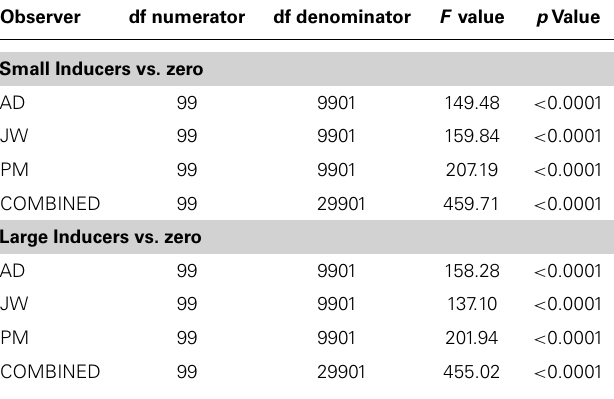
Table 1 | Degrees of freedom, F values and p values obtained from the single-sample Hotelling T 2 statistic, testing the radial classification images obtained for each human observer and the combined data across observers in each condition against the null hypothesis of zero correlation.